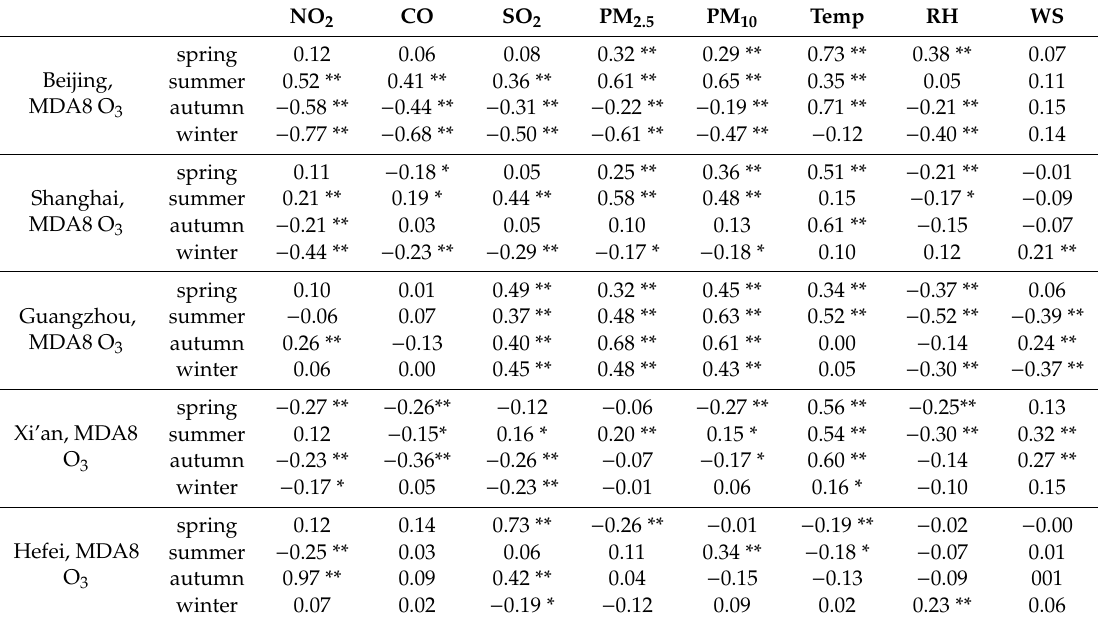
Table 2. Spearman–Rank correlation coe ffi cient Values of MDA8 O 3 with the other five criteria air pollutants and meteorological